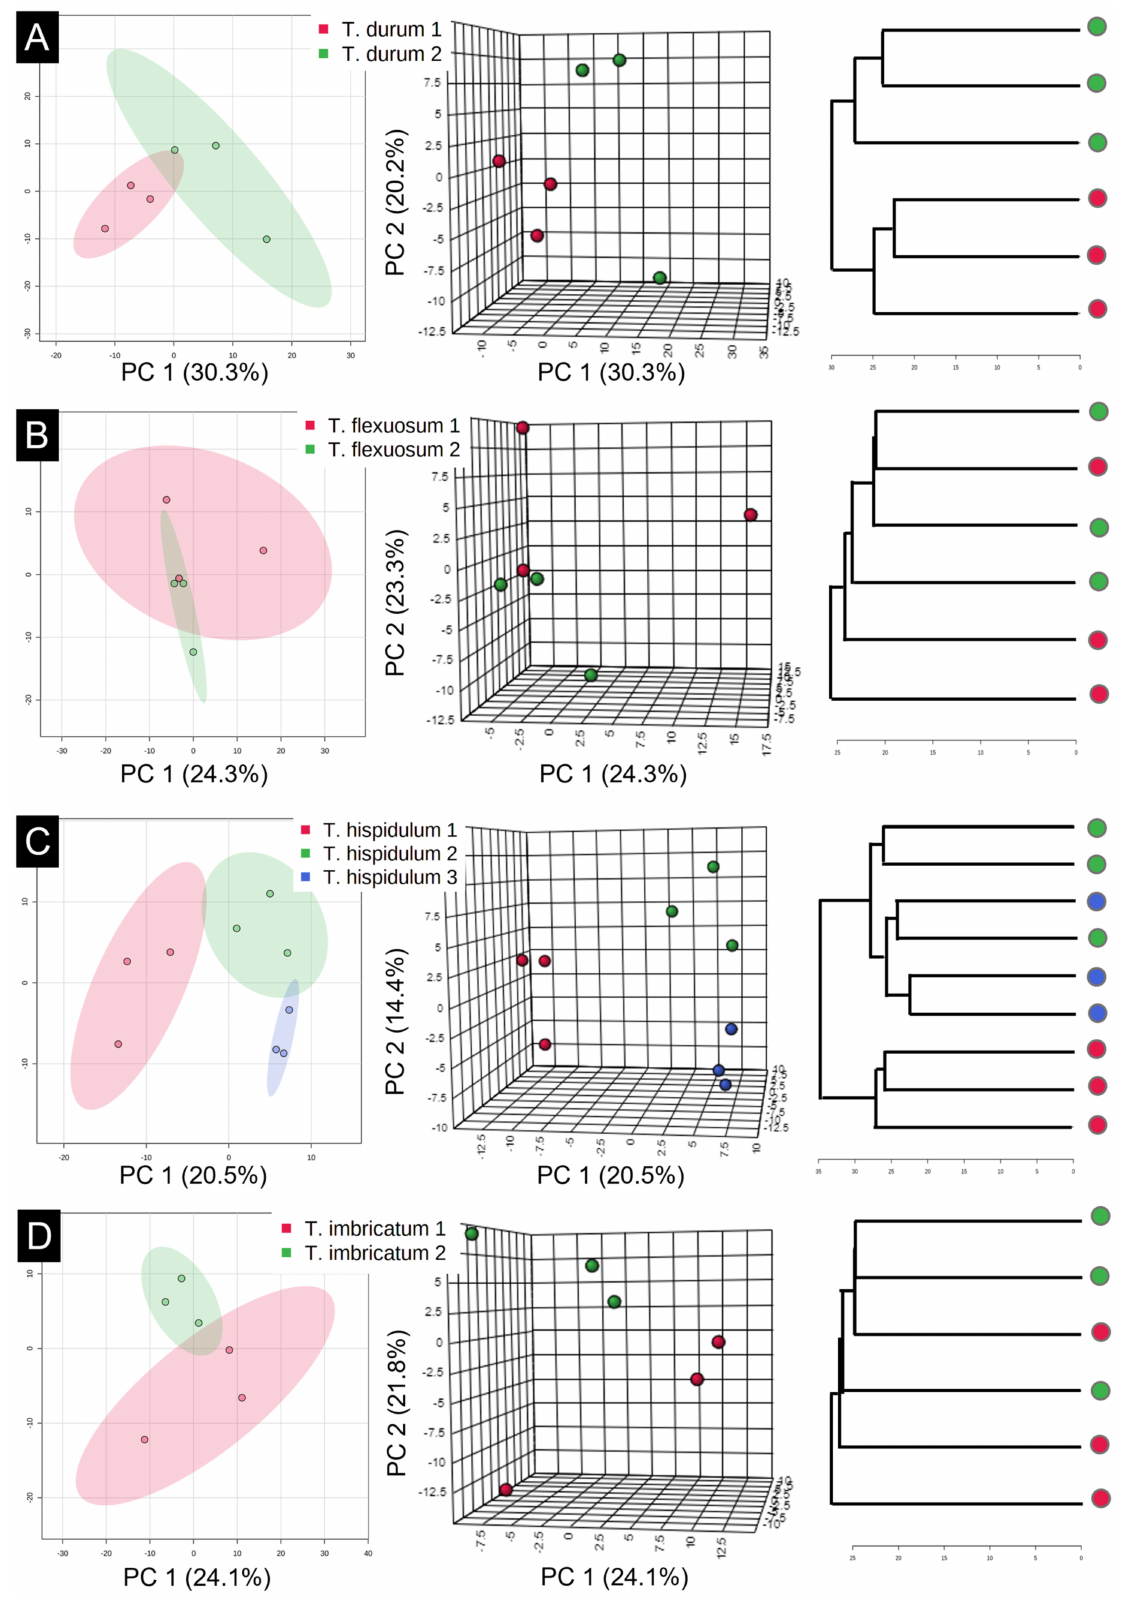
Figure 5. Two- and three-dimensional PCA plots and hierarchical clustering dendrograms comparing the phenolic compound compositions of different populations of four Thesium species ( A ). T. durum . ( B ). T. flexuosum . ( C ). T. hispidulum . ( D ). T. imbricatum . For each species, different populations are indicated by different